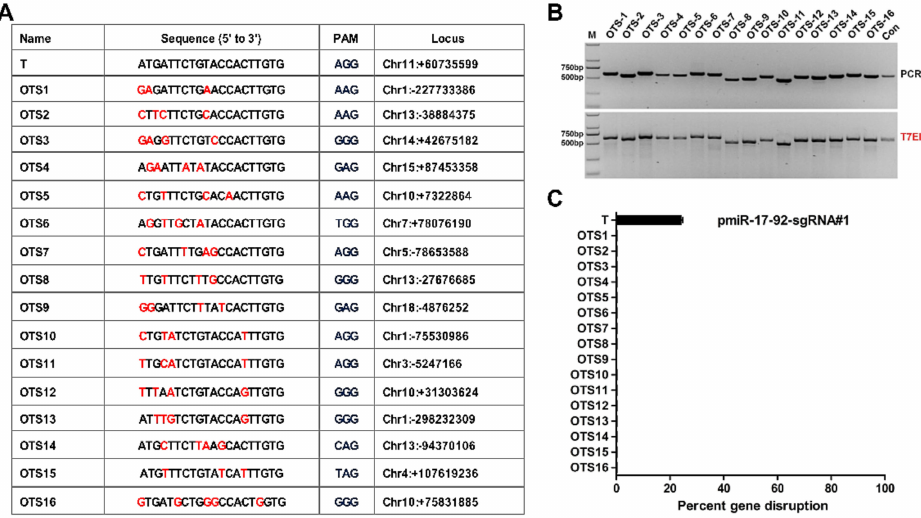
Figure 7. Off-target site analysis in positive PFF clones. ( A ) List of potential off-target sites homologous to sgRNA#1/cas9. T represents target site and OTS1~OTS16 represents 16 potential off-target sites. PAM sequences are labelled in blue. Base substitutions are shown in red. ( B ) PCR products covering 16 potential off-target sites were subjected to the T7E1 assay and no mutation was found in any potential off-target sites. M: DNA Marker 2000. ( C ) Off-target mutagenesis measurement of p miR-17-92 cluster. Indel frequencies were measured by TIDE analysis. All TIDE analyses below the detection sensitivity of 1.5% were set to 0%. All values are the mean ± S.E.M., n = 3. T: target site. OTS: off-target